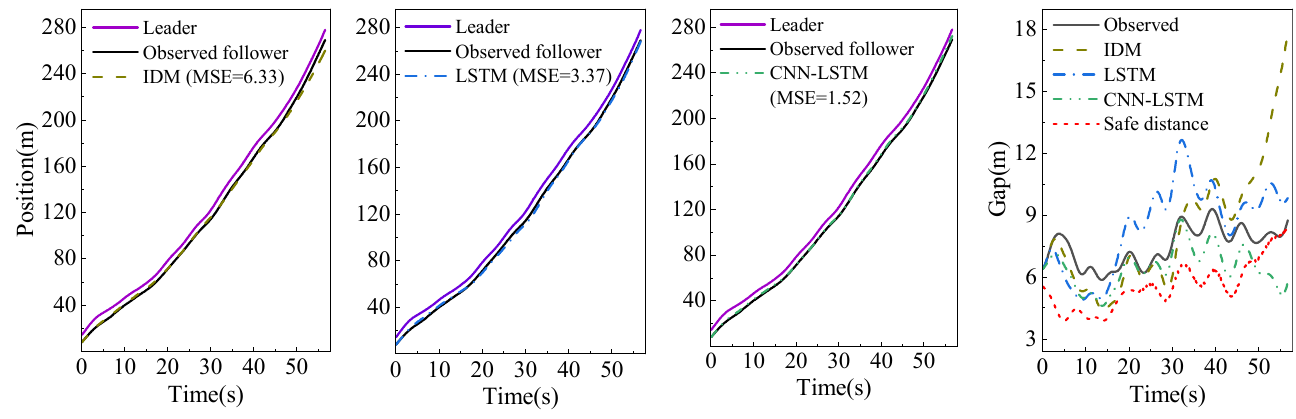
Figure 7. Aggressive driving behavior.